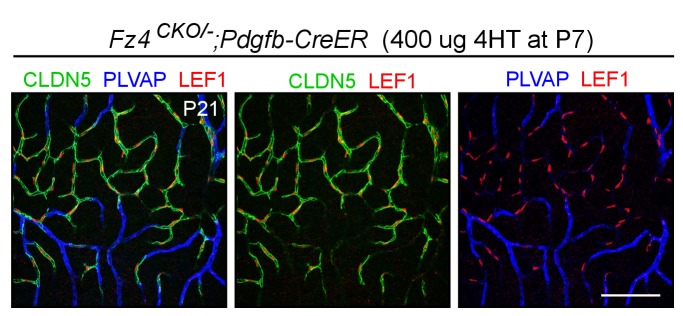
Nuclear LEF1 accumulates in phenotypically WT Fz4+/-retinal ECs and is undetectable in Fz4-/-retinal ECs.Flatmount of a mosaic P21 Fz4CKO/-;Pdgfb-CreER retina in which ~50% of ECs had recombined the Fz4CKO allele two weeks earlier at P7. WT ECs are CLDN5+/PLVAP- and Fz4-/-ECs are CLDN5-/PLVAP+. Nuclear LEF1 accumulates exclusively in CLDN5+/PLVAP- ECs. Scale bar, 100 μm.